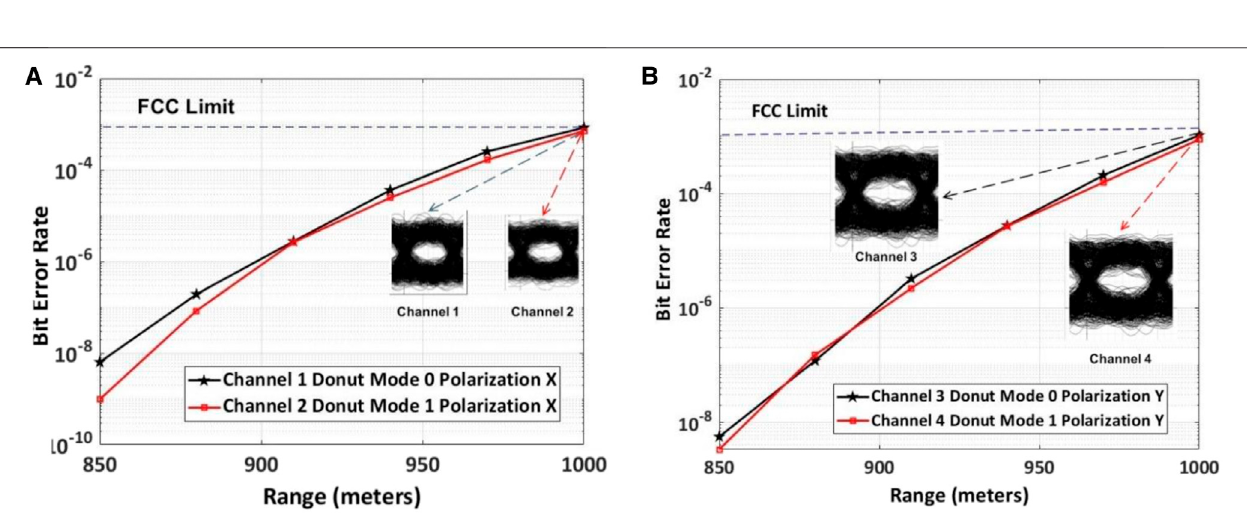
FIGURE 7 | Measured BER under partially hazy/rainy atmospheric condition (A) Channel 1 and Channel 2 (B) Channel 3 and Channel 4